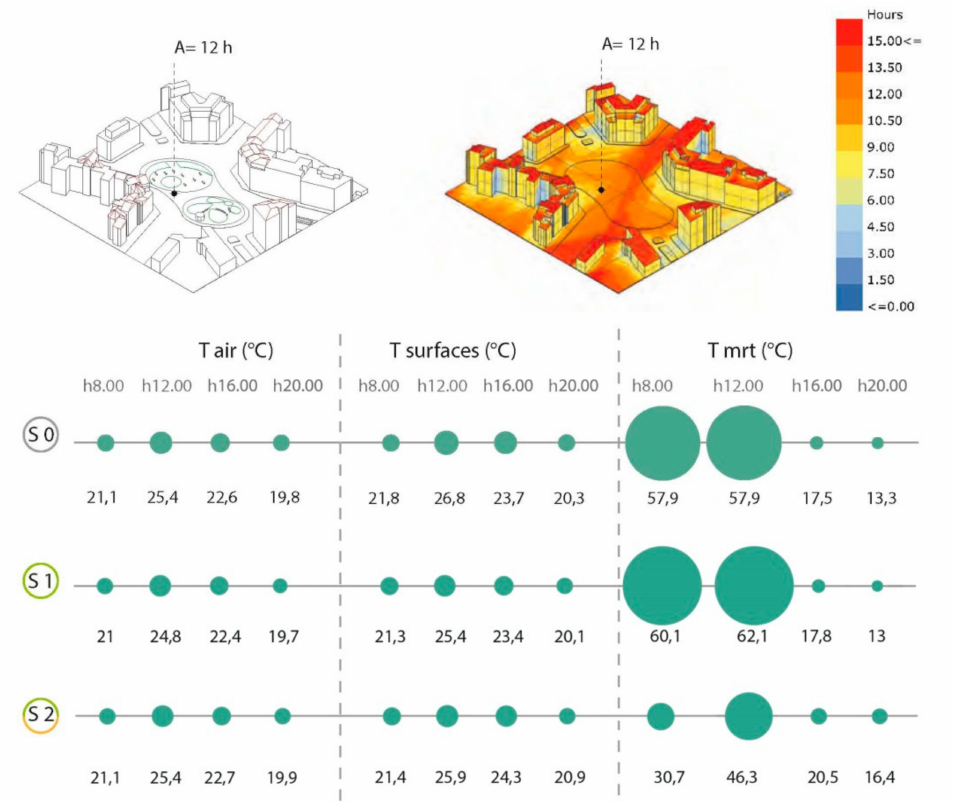
Figure 12. Final comparison between S1, S2 during summer (21